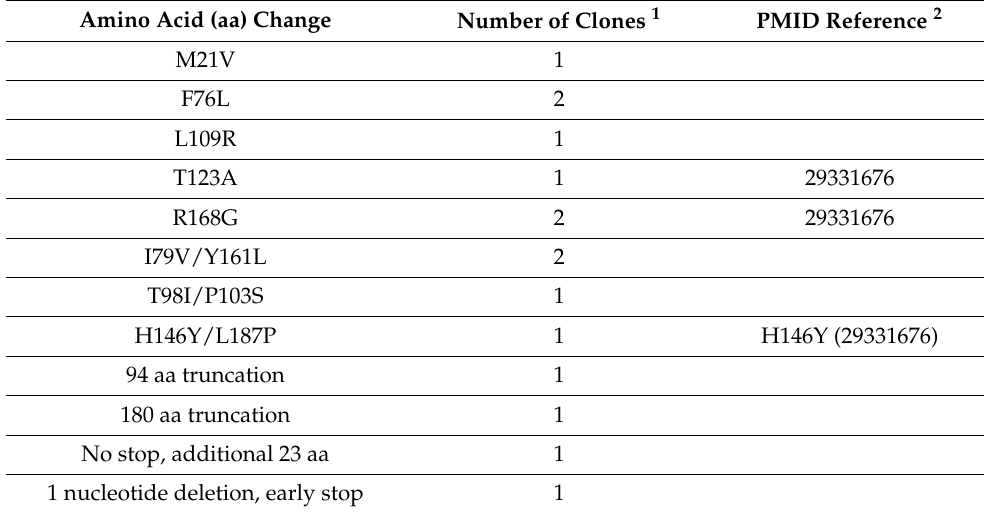
Table 1. Amino acid residues in 1918 PA-X identified in the bacterial-based assay. Amino Acid (aa)